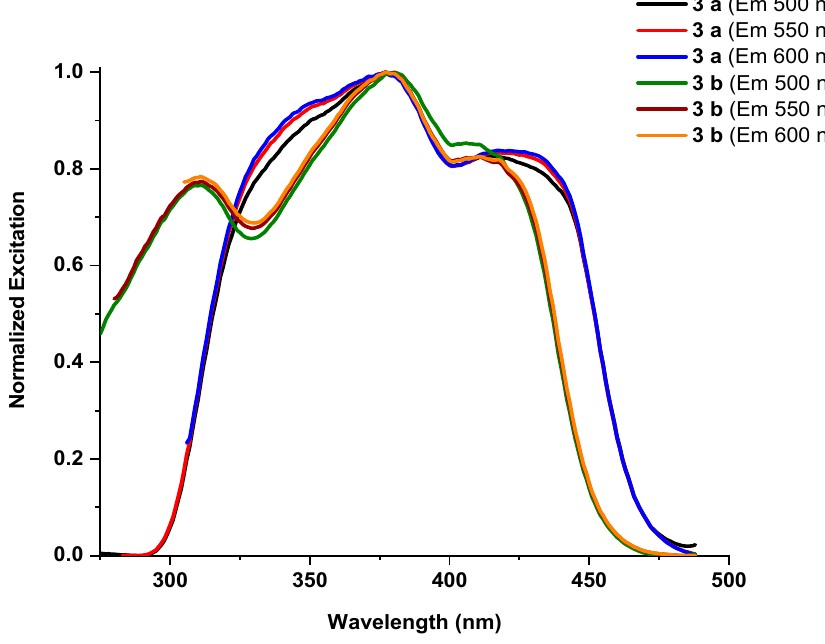
Figure 28. Normalized fluorescence excitation spectra of polymers 3 a,b in the solid state. The fluorescent properties of polymer 3 a in the solid state at different temperatures were studied and the results are presented in Figure 29. As shown, during the transition from 30 to 220 °C the intensity of fluorescence drops drastically and a shift of maximum fluorescence to the short-wavelength region is observed. Therefore, this DBMBF 2 -grafted polymer can be used as a fluorescent temperature sensor.